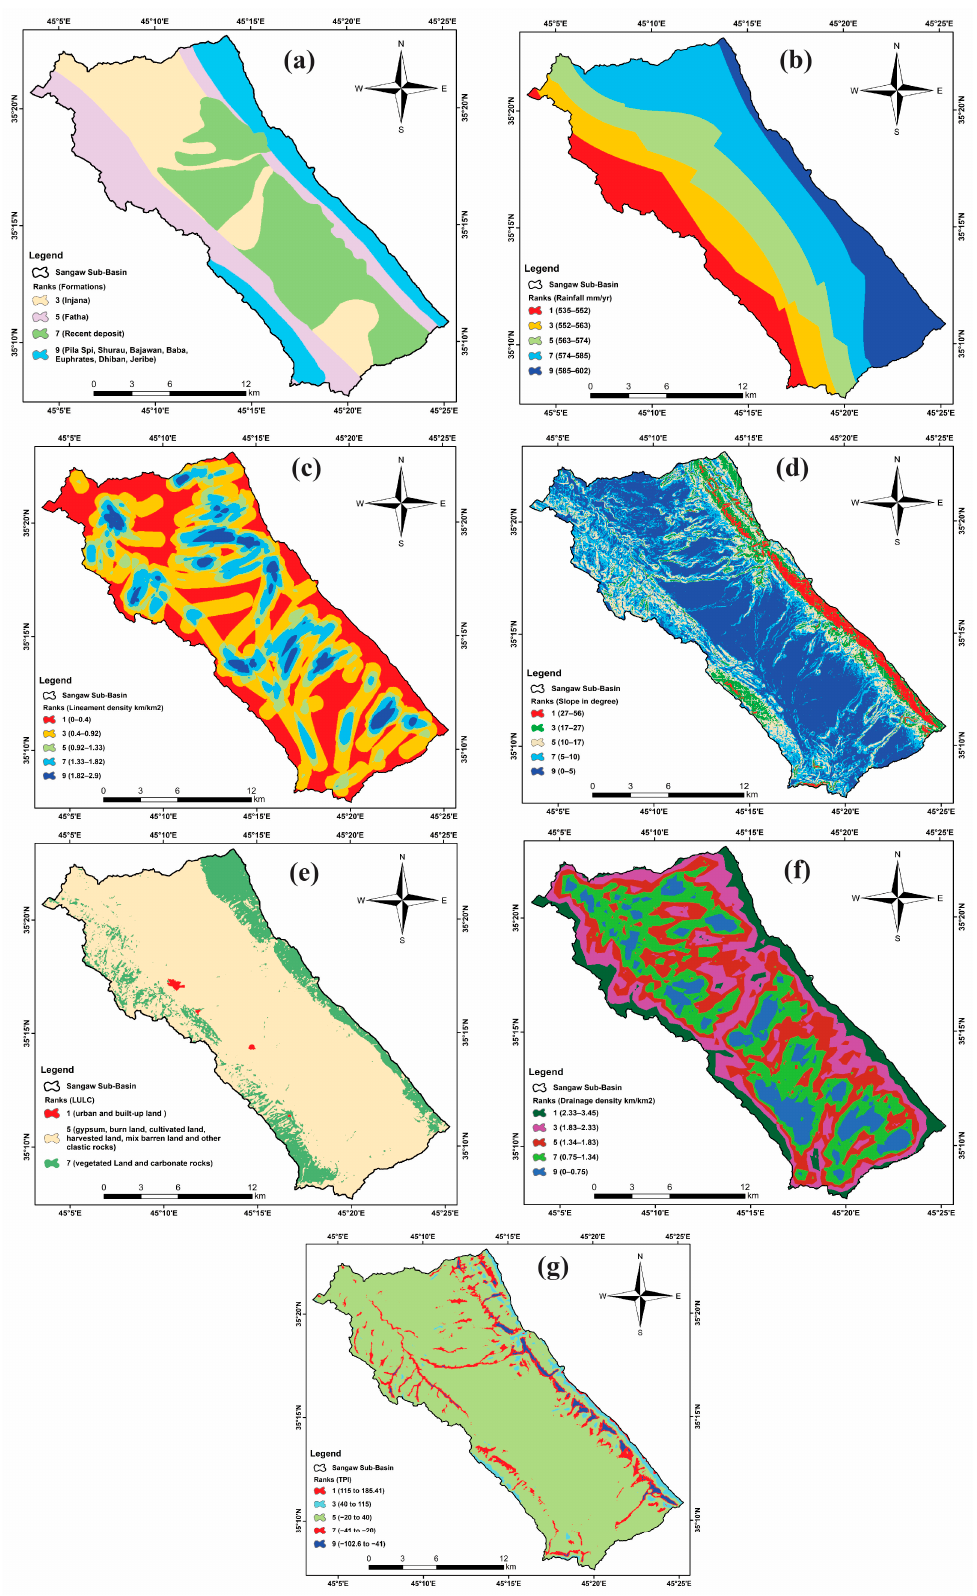
Figure 5. Thematic layers of study region: ( a ) Geology, ( b ) Rainfall, ( c ) Lineament density, ( d ) Slope, ( e ) LULC, ( f ) Drainage density, and ( g )